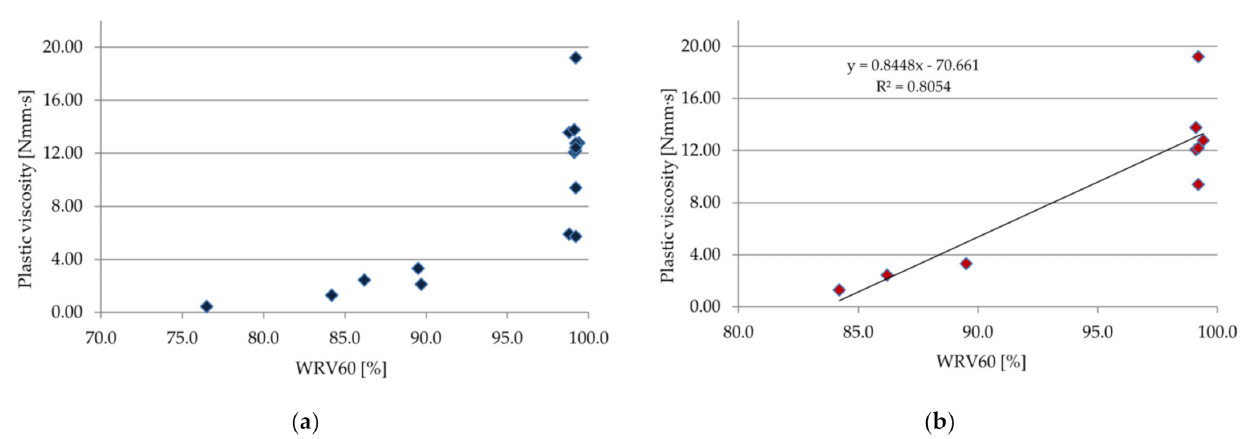
Figure 12. Correlation between plastic viscosity and WRV10 ( a ) for all samples, and ( b ) only for samples with cement– lime binder.